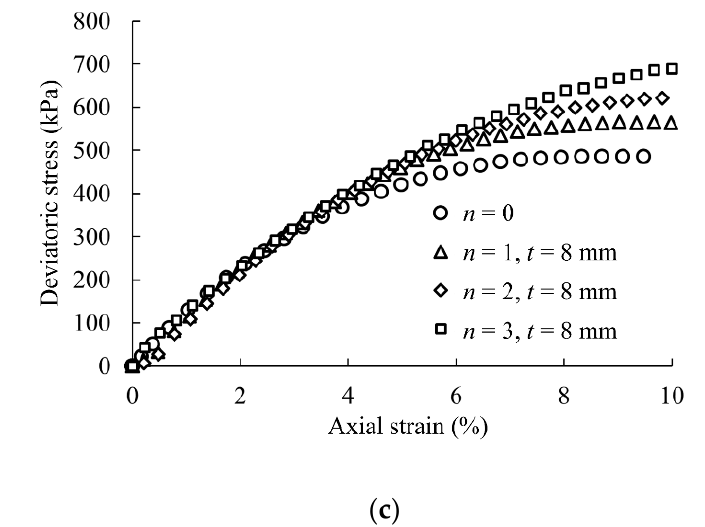
Figure 9. The deviatoric stress–axial strain curves of the LGSCR samples at different numbers of sand layers and confining pressures of ( a ) 150 kPa, ( b ) 250 kPa, and ( c ) 400 kPa. Figure 10 depicts the deviatoric stress–axial strain curves of the LGSCR samples at confining pressures of 150, 250, and 400 kPa and with different thicknesses of sand layers. As seen in this figure, the strength of the LGSCR samples under a specific confining pressure enlarges with an increase in the t value. Compared with the SCL samples, the LGSCR samples have a higher σ p at the same thickness of sand layers. However, the trends of the strain-softening degree and the ε n corresponding to the σ p with the thickness of sand layers of the LGSCR samples are similar to those of the SCL samples. Therefore, the setting mode of thin multi - sand layers should also be adopted for the LGSCR structures in engineering applications.